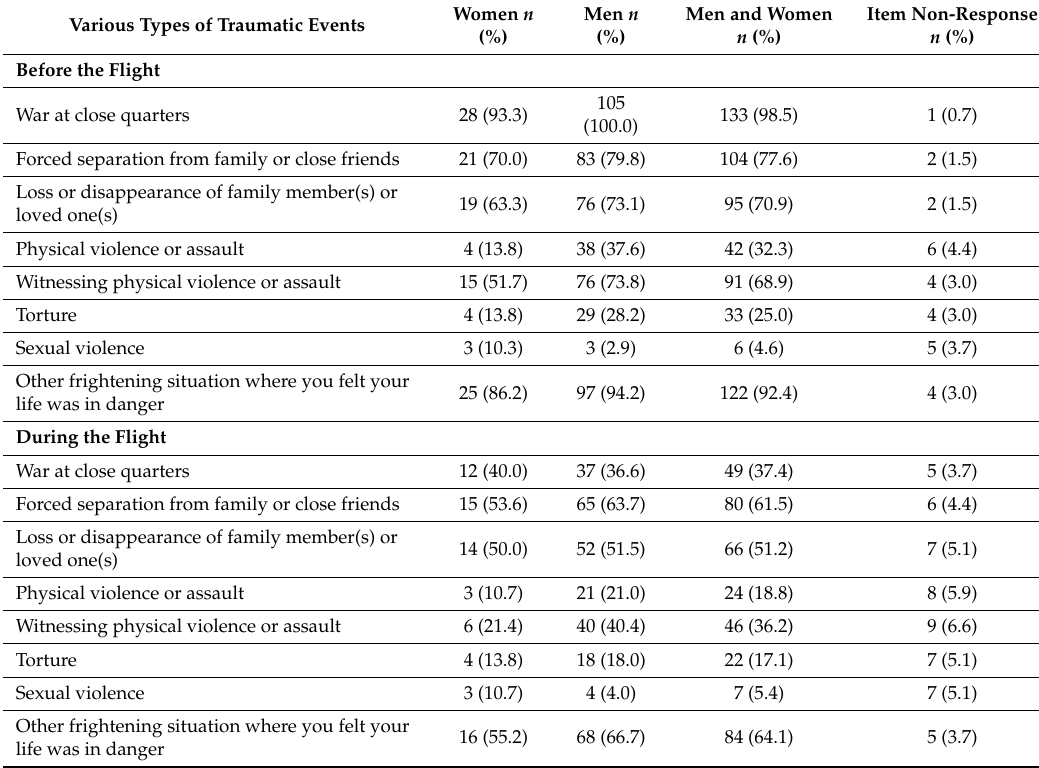
Table 1. Prevalence of PTEs and non-response rates for each item among the respondents.